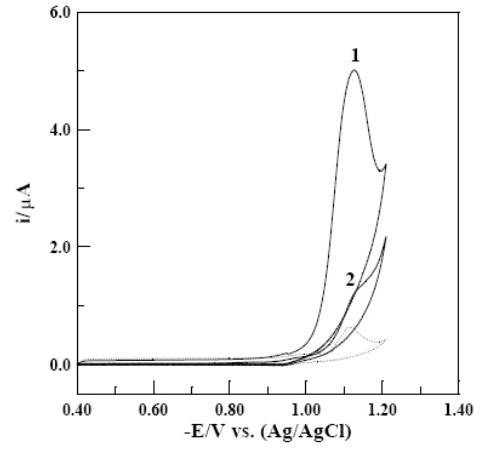
Fig. 2 Cyclic voltammograms for 1 × 10 − 6 M bulk tolmetin in a perchloric acid solution of pH 2 at v = 0 . 2 V s − 1 after adsorptive accumulation onto the HMDE for 30 s: under open circuit conditions (dashed scan), at E acc = − 0 . 4 V (scans 1 &